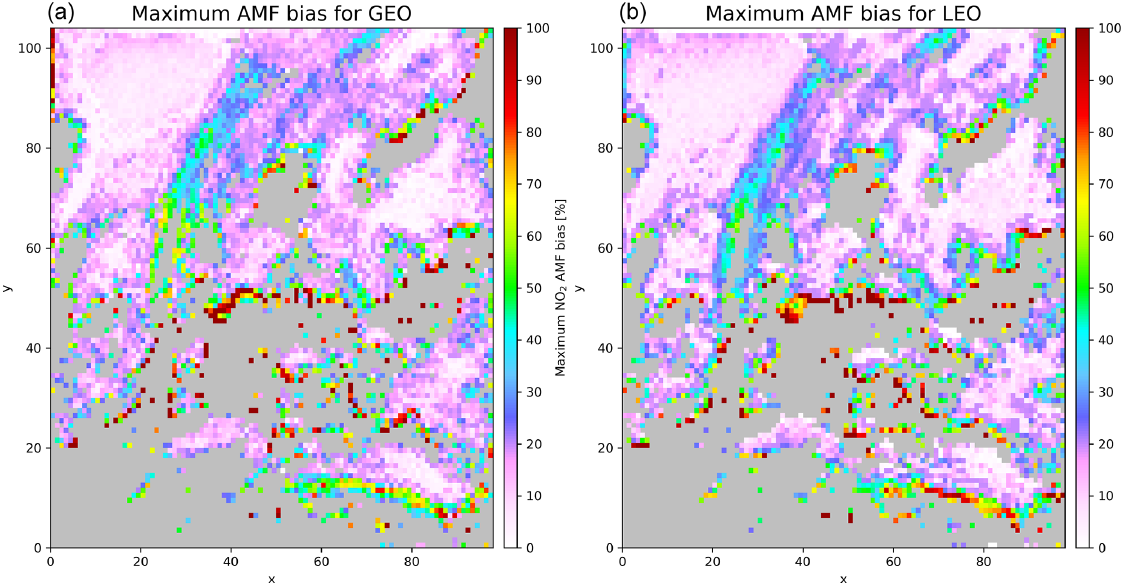
Figure 7. Maximum NO 2 AMF bias for each pixel for (a) geostationary geometry and (b) low-earth-orbiting